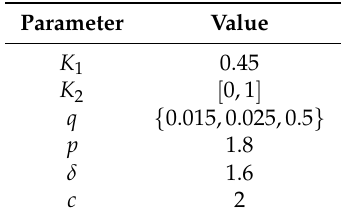
Table A1. Parameter values for the numerical